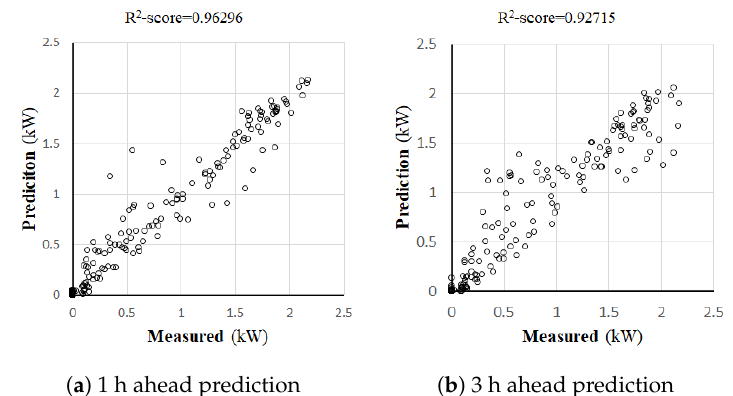
Figure 16. Scatter plots of short-term forecast results (RNN layers = 3, time steps = 12, sampling interval = 30